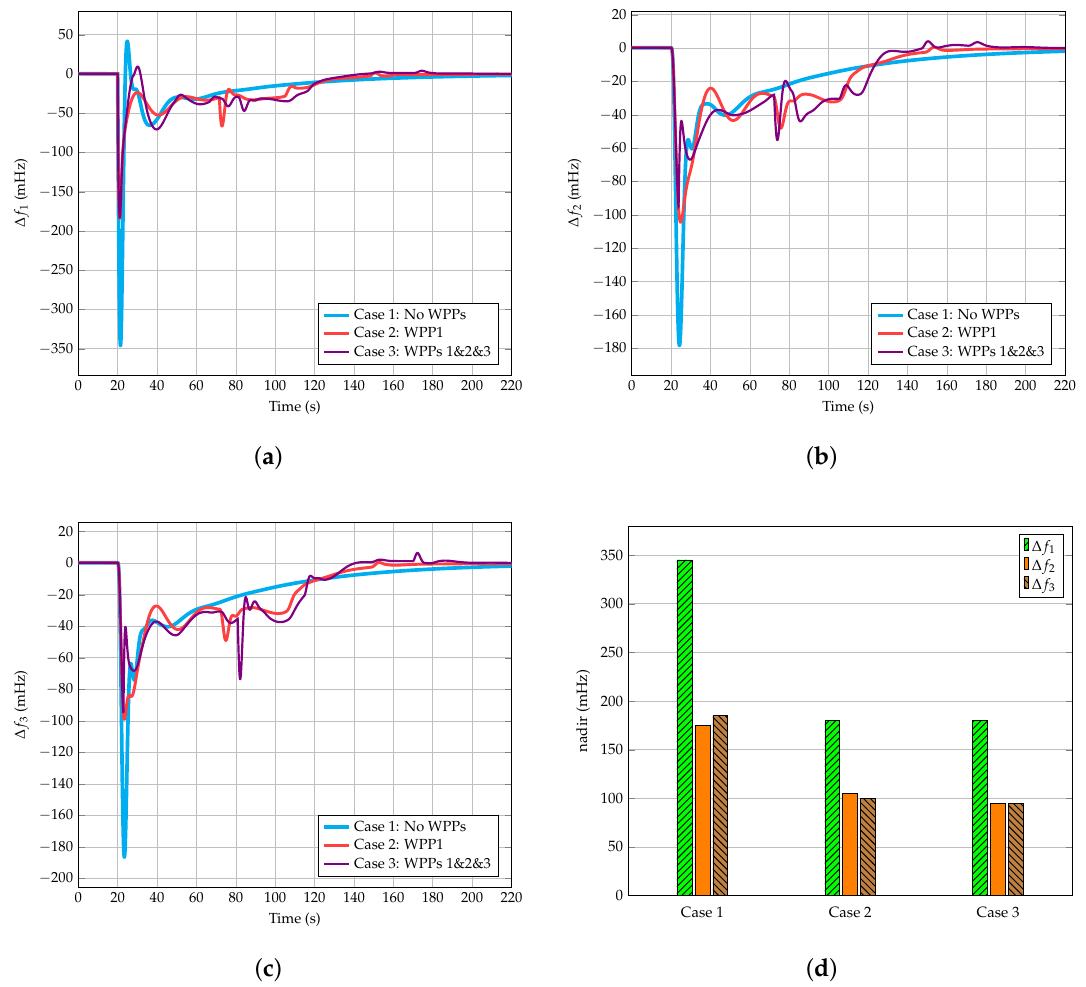
Figure 12. Frequency oscillations: Area 1 under power imbalance ( ∆ P L ,1 ); ( a ) frequency oscillations in Area 1 ( ∆ f 1 ); ( b ) frequency oscillations in Area 2 ( ∆ f 2 ); ( c ) frequency oscillations in Area 3 ( ∆ f 3 ); ( d ) nadir values: case